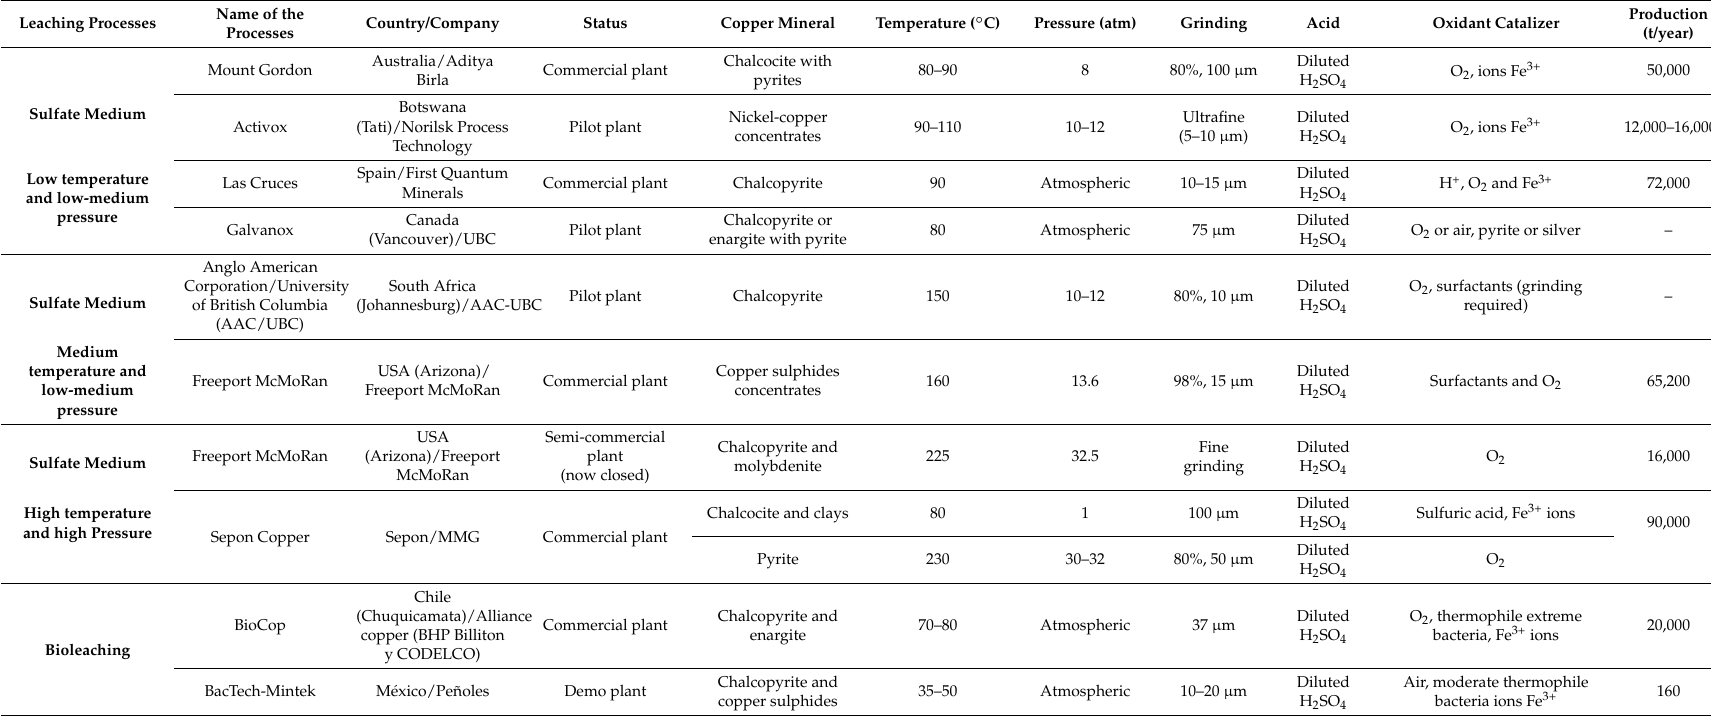
Table 1. Current hydrometallurgical processes for leaching copper. Information obtained from